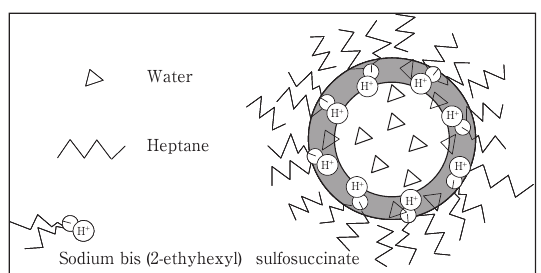
Fig. 4 SEM (A,C) and TEM (B,D) of hollow SiO ticles 53) .